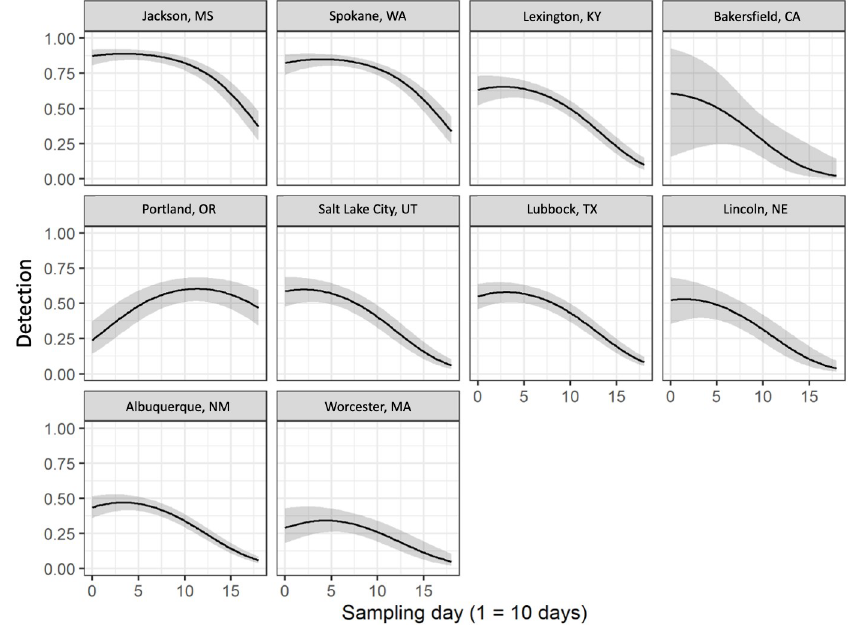
Fig 3. Detection probability of American robin: Robin Detection probability as a function of survey date for each city predicted from the top model. Grey shaded area represents 95% confidence intervals and solid is the expected value. Date of peak detection probability varied between cities, but tended toward the start of the study period, which coincides with robin breeding behavior.